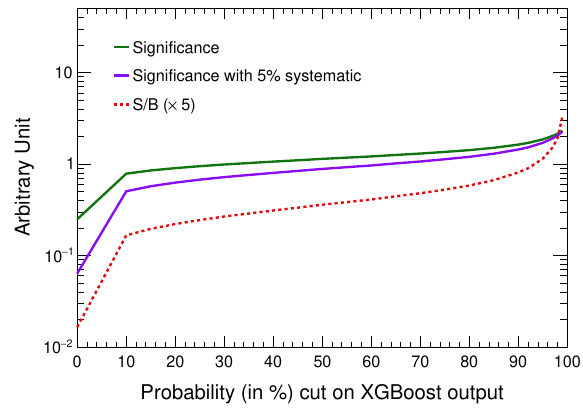
Figure 8 . The variation of significance (with ( 5% ) and without systematic uncertainty) and S/B is shown as a function of the probability cut on the XGBoost output for the WW ∗ γγ